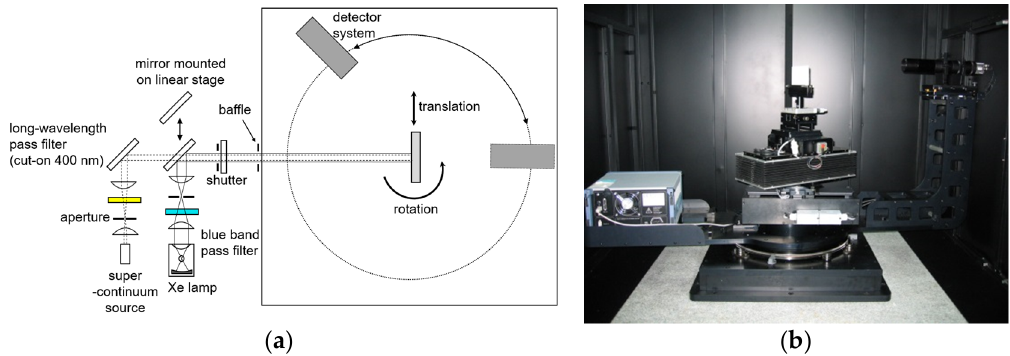
Figure 3. Schematic diagram ( a ) and picture ( b ) of the hyperspectral gonioreflectometer used for BRDF measurements on tarps.